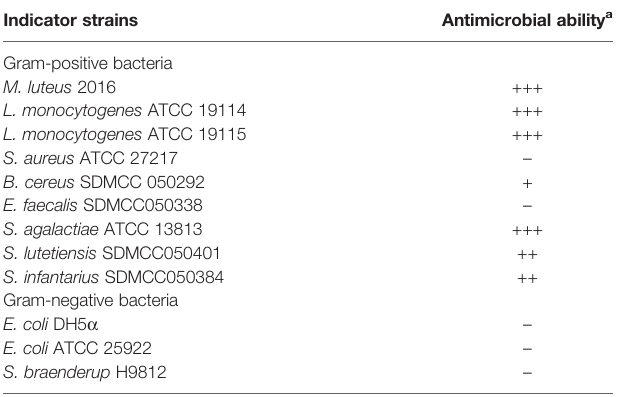
a Symbols show the antimicrobial ability of B. subtilis LF11: – , no inhibition; +, weak (Diameter of bacteriostatic zone <14 mm); ++, good (Diameter of bacteriostatic zone 15 – 19 mm); +++, strong (Diameter of bacteriostatic zone >20